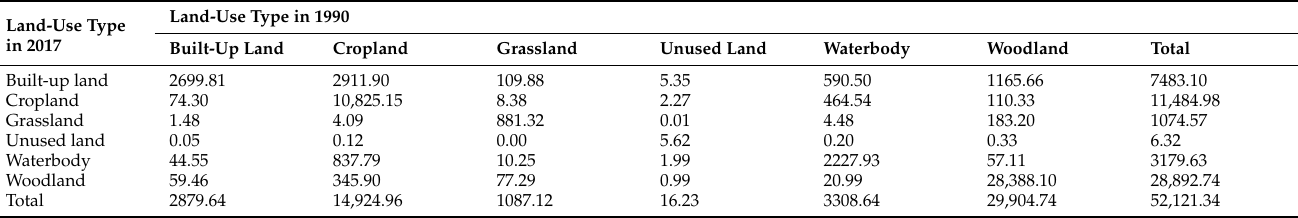
Table 4. Land-use transitions in the PRD between 1990 and 2017 (km 2